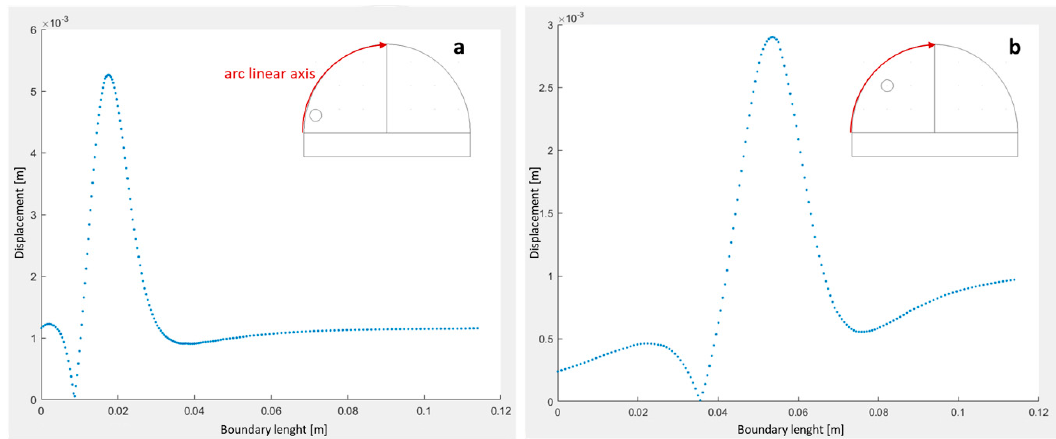
Figure 7. Differential displacement between abnormal and healthy breast as a function of nodule position evaluated along the boundary #1, indicated in red in the inset. ( a ) 125 kPa nodule placed superficially and closer to the boundary (see inset); and ( b ) 125 kPa nodule placed deeper in the breast and near the center (see inset).